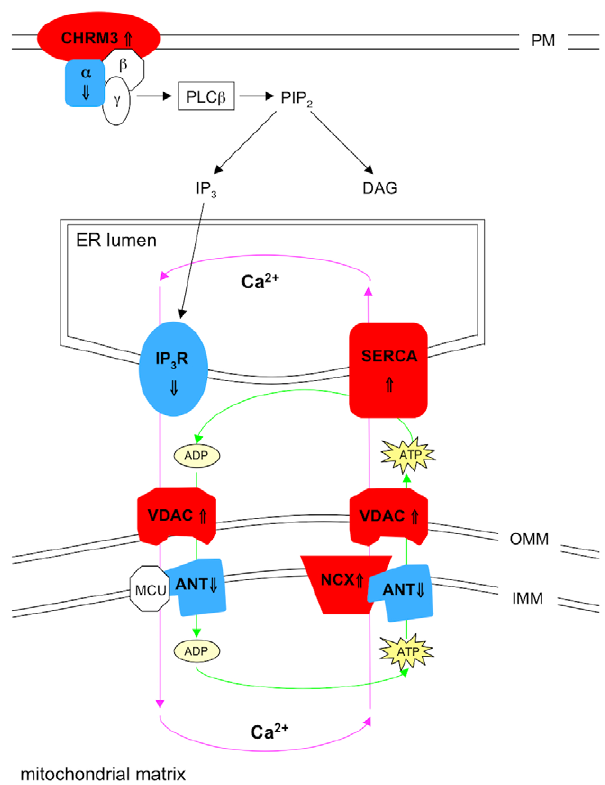
Figure 5. Defects in calcium signalling as a result of CHMP2B mutations. Downregulation of the a -subunits, G q ( Y ) and G q11 ( Y ) indicates a decrease in PLC b activation, despite upregulation of the cholinergic receptor CHRM3 ( X ). A decrease in PLC b activity would reduce the amount of phosphatidylinositol 4,5-bisphosphate (PIP 2 ) hydrolysed to inositol 1,4,5-triphosphate (IP 3 ) and diacylglycerol (DAG). Combining the decrease in IP3, with downregulation of its receptor, IP3R ( Y ), would reduce the opening of a Ca 2 + -release channel on the ER membrane, which allows Ca 2 + to exit the ER lumen into the cytosol. SERCA, which pumps Ca 2 + out of the cytoplasm into the ER lumen is upregulated, so these findings predict an increased Ca 2 + concentration in the ER lumen. Upregulation of NCX1( X ) and VDAC3( X ), and downregulation of ANT3( Y ), predict that mitochondria are increasing the amount of calcium pumped out of the matrix, but decreasing the amount of ATP leaving the organelle. Amplifying the aberrant intracellular calcium levels, in addition to reducing the amount of energy available for cellular processes. (PM=plasma membrane; OMM=outer mitochondrial matrix; IMM=inner mitochondrial